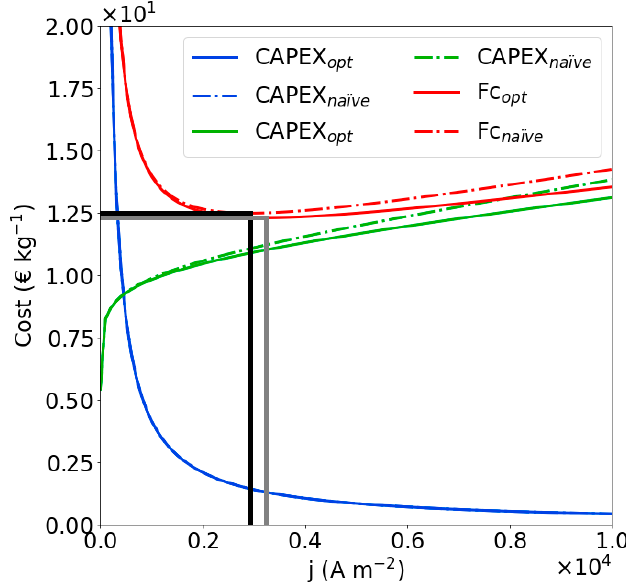
Figure 17. CAPEX, OPEX, and total cost for the naïve solution (dashed line) and optimum solution (solid line) depending on the current density ( IC s = 14,000 € m − 2 , EC = 0.17 € kWh − 1 , b an = b cath = 0.15 V dec − 1 ).